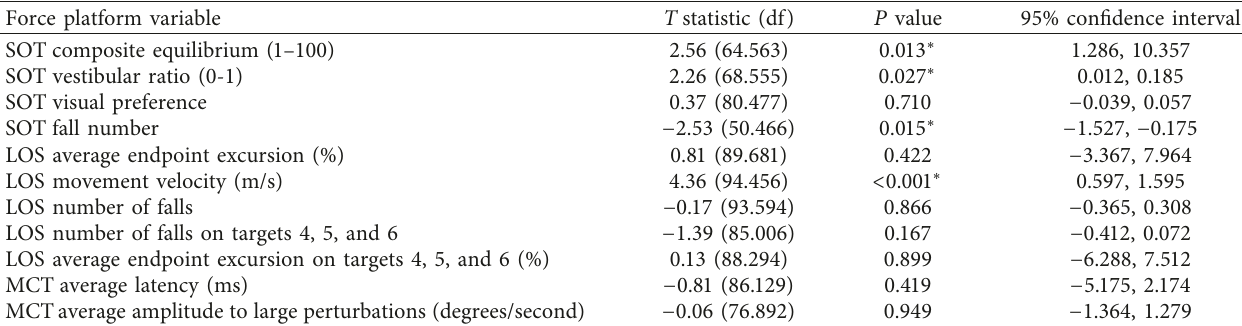
Table 4: Discriminative validity of force platform measures between PD and healthy